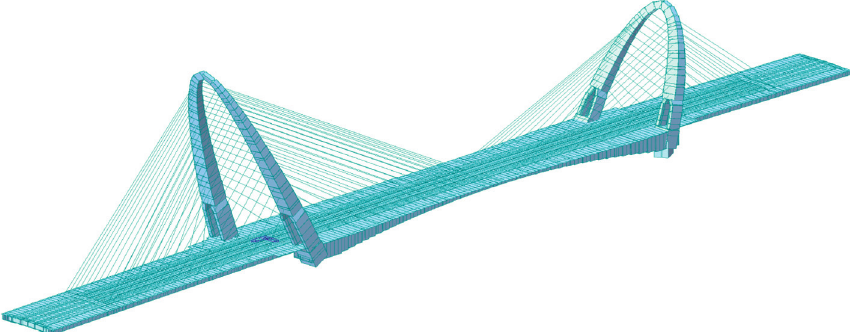
Figure 11: FEM of the Yong-ding cable-stayed